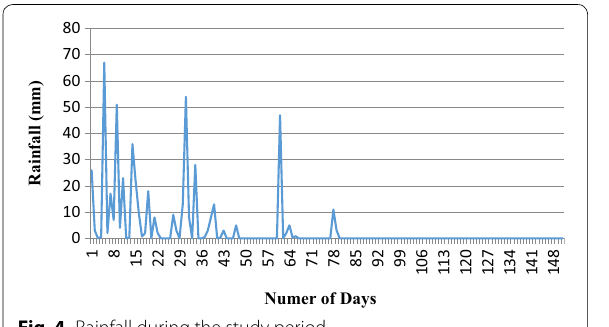
Fig. 4 Rainfall during the study period